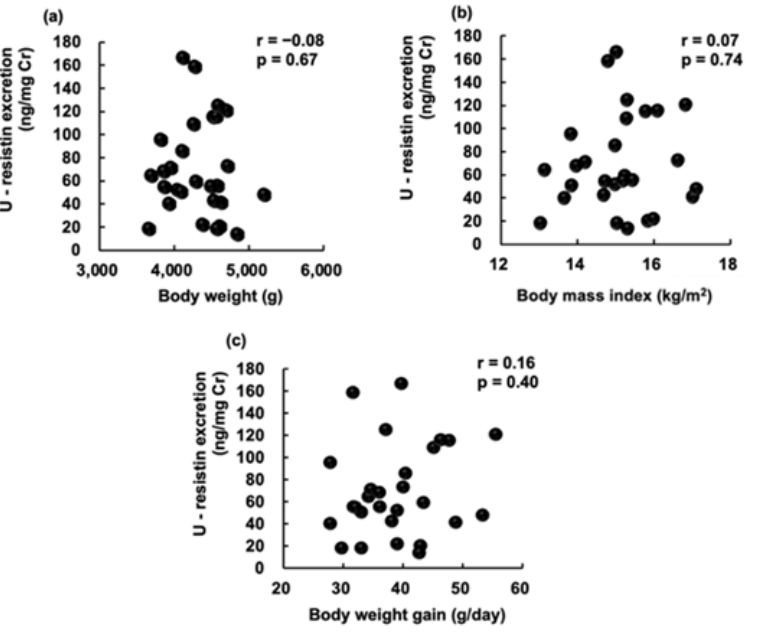
Figure 2. Correlation of urinary (U) resistin level to ( a ) infant’s body weight; ( b ) infant’s body mass index (BMI); ( c ) body weight gain. Each dot represents an independent sample.